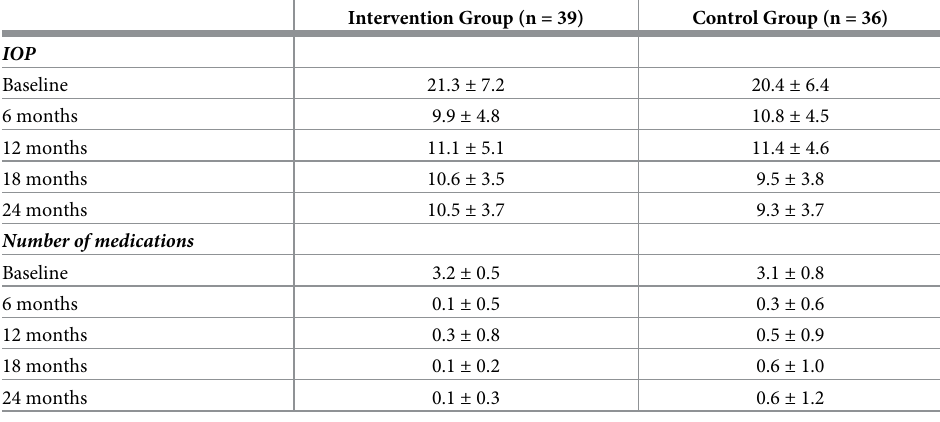
Table 2. Intraocular pressure and number of medications data at all